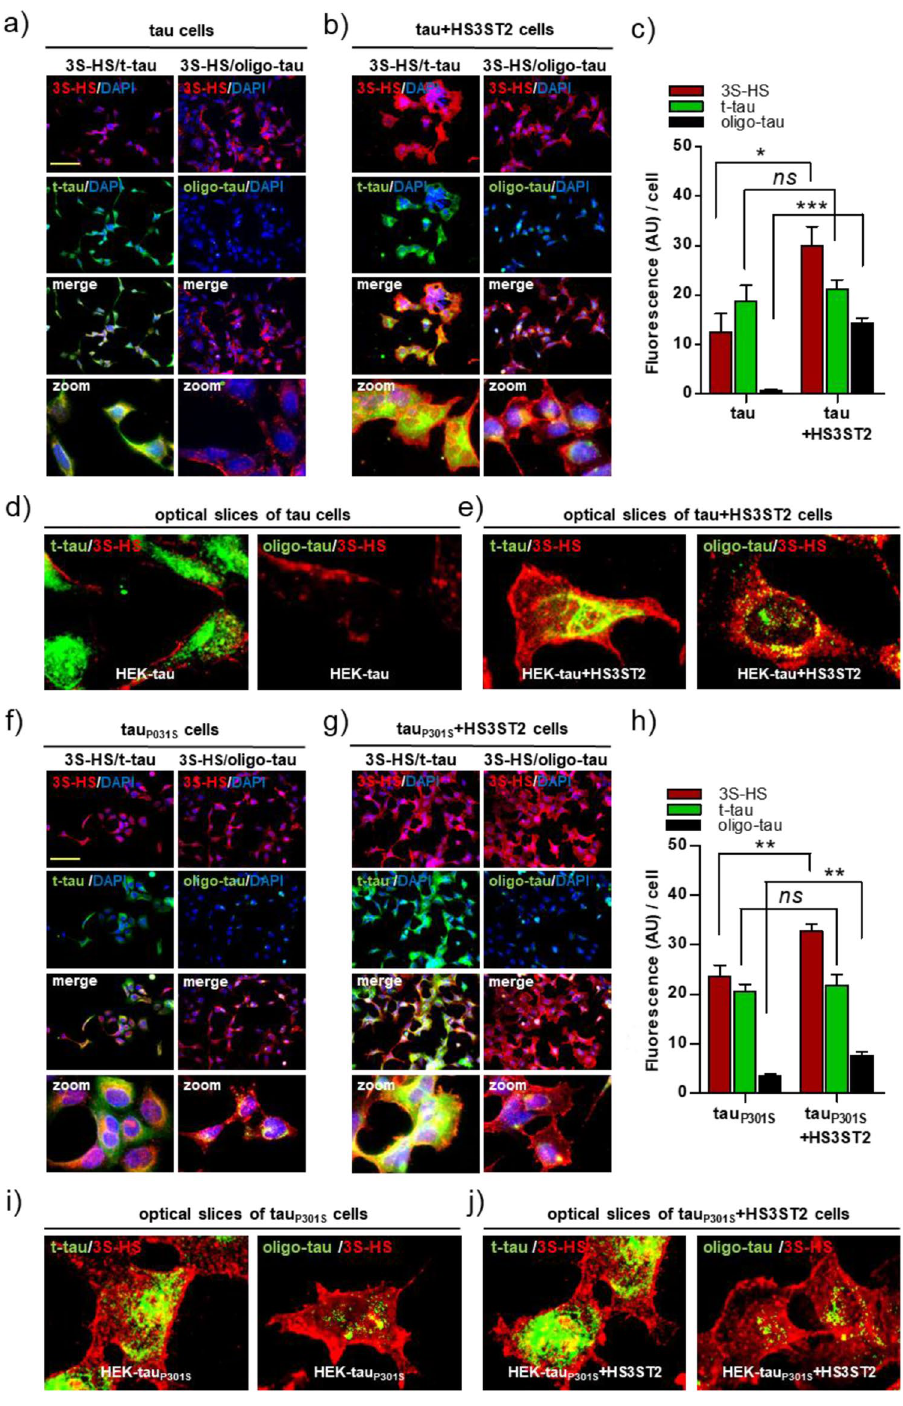
Figure 5. Intracellular 3S-HS and tau oligomers in cells expressing HS3ST2 and tau or tau P301S . Cells were immunoassayed with antibodies against 3S-HS (HS4C3, red), total tau (t-tau; K9JA antibody; green), and oligo-tau (T22 antibody; green). Images were recorded with a microscope IX81 Olympus with confocal option. Magnification was 20× or 60× for confocal slices (immersion oil). ( a,b ) Representative image of 3S-HS, tau, and oligo-tau staining in HEK cells expressing tau together or not with HS3ST2. ( c ) Fluorescence intensity quantification of 3S-HS, t-tau, and oligo tau signals in HEK+tau vs HEK+tau+HS3ST2 cells. Mean values ± SD ( n = 3) are represented. ( d ) Confocal slices showing non-intracellular 3S-HS and no tau oligomers in HEK+tau cells. ( e ) Confocal slices showing intracellular 3S-HS and tau oligomers accumulation in HEK+tau cells. ( f,g ) Representative images of 3S-HS, tau, and oligo-tau staining in HEK cells expressing tau P301S together or not with HS3ST2. ( h ) Fluorescence intensity quantification of 3S-HS, t-tau, and oligo tau P301S signals in HEK+tau P301S vs HEK+tau P301S +HS3ST2 cells. Mean values ± SD ( n = 3) are represented. ( i ) Confocal slices showing intracellular 3S-HS and tau oligomers in HEK+tau P301S cells. ( j ) Confocal slices showing intracellular 3S-HS and tau oligomers in HEK+tau P301S and HEK+tau P301S +HS3ST2 cells. Image analyses were calculated by the unpaired and two-tailed Student’s t test, as indicated (*** P < 0.001; ** P < 0.01; * P < 0.05; ns = not